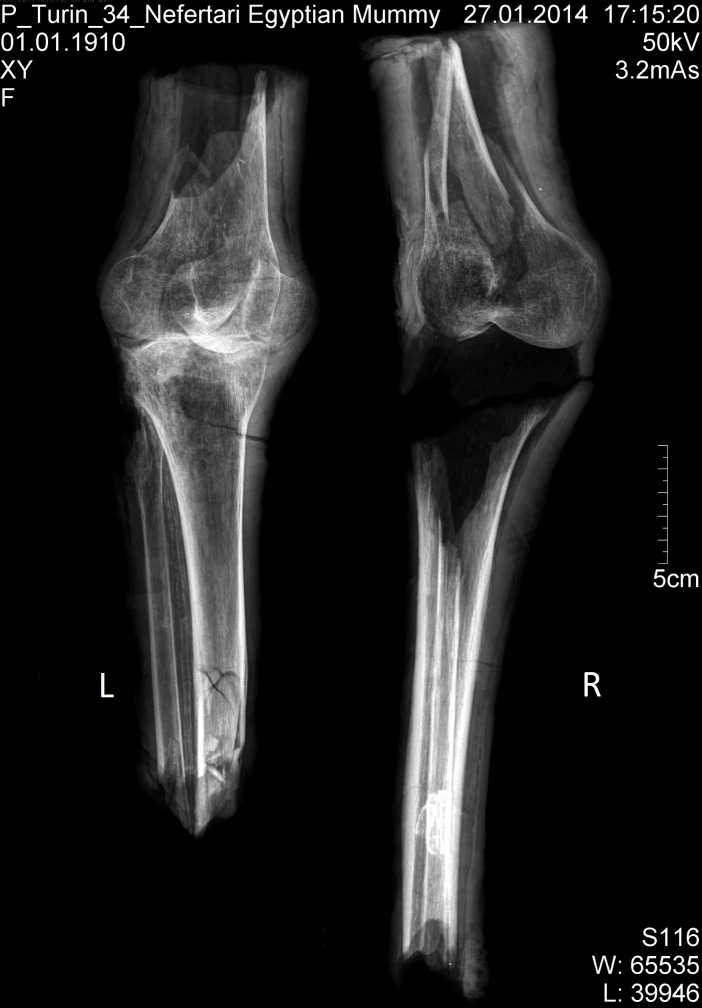
X-ray; arranged as seen in Fig 3.